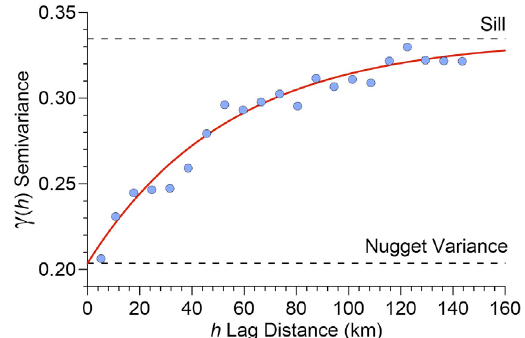
Figure 3. Semivariogram (blue dots) of the anisotropic component (I ) of intensities fitted by an exponential A model (red line). Nugget and sill variance levels are marked by dashed lines.